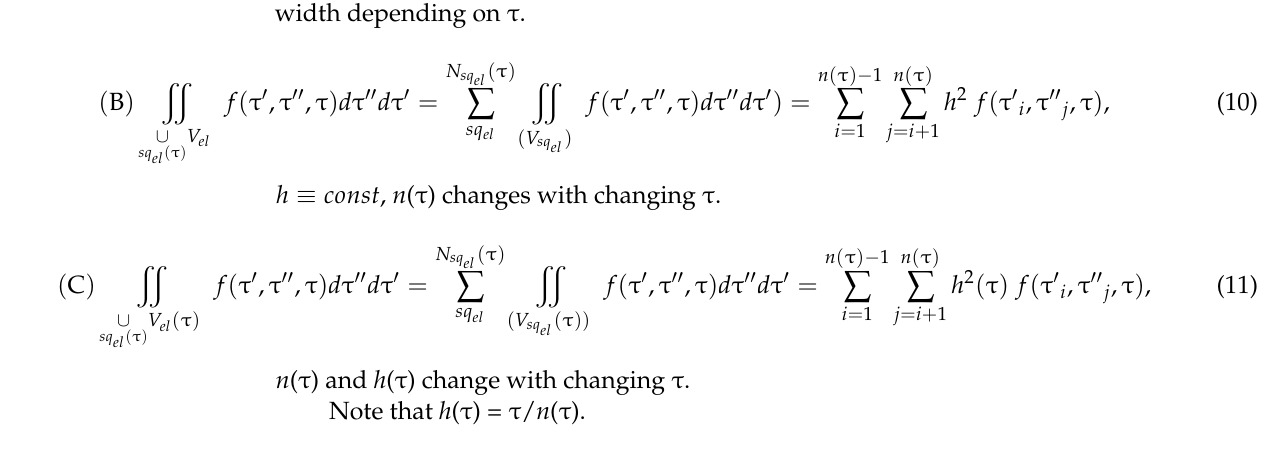
grid width depending on τ .